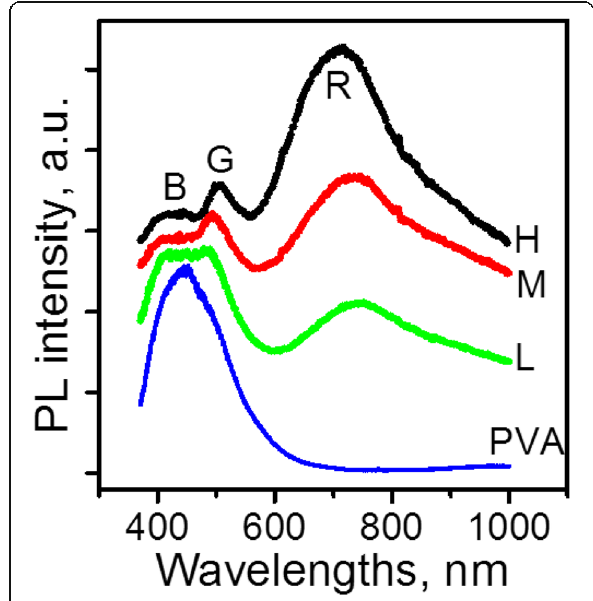
Fig. 1 Photoluminescence spectra of the samples L , M , and H composites and pure